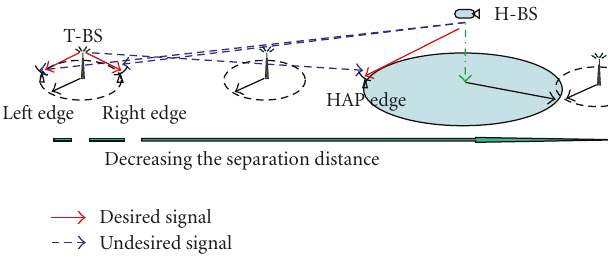
Figure 5: EOC area performance evaluation scenario with variable separation distances.